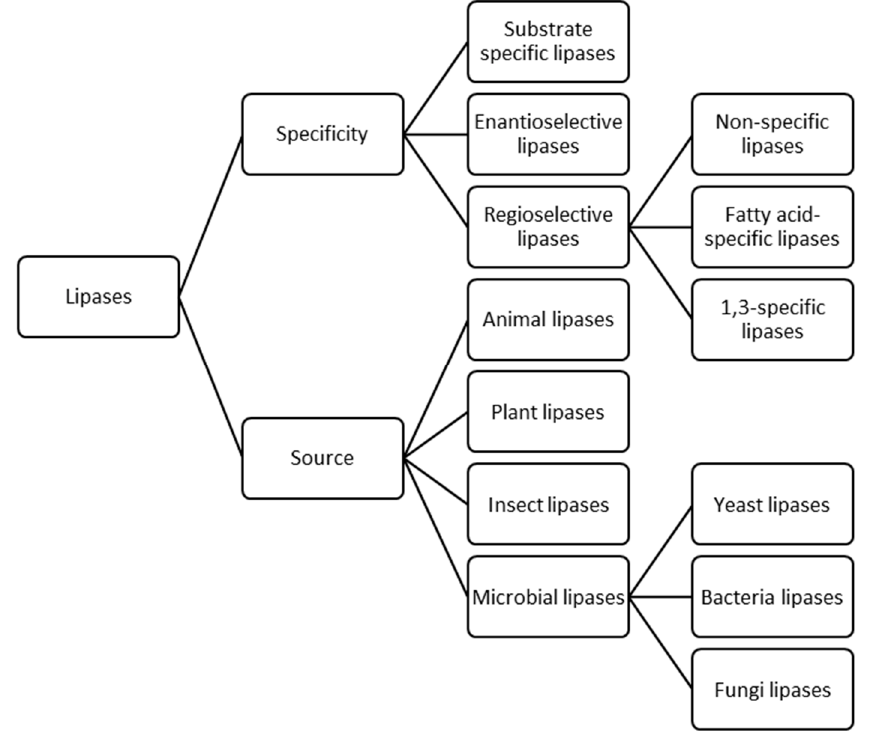
Figure 2. Classification of lipases based on their specificity and source.